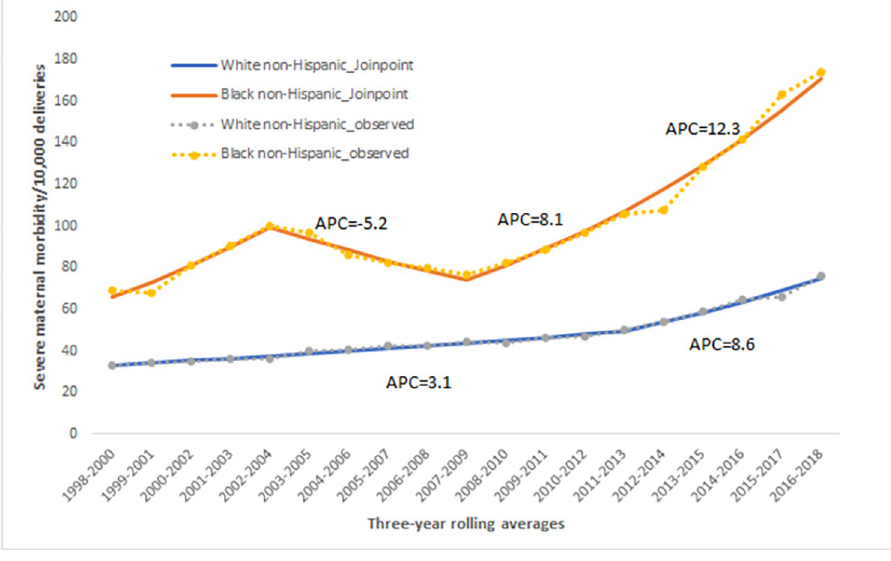
Fig 3. Severe maternal morbidity a for Black and White birthing people: Massachusetts, 1998–2018. a Severe maternal mortality without blood transfusion (SMM20).